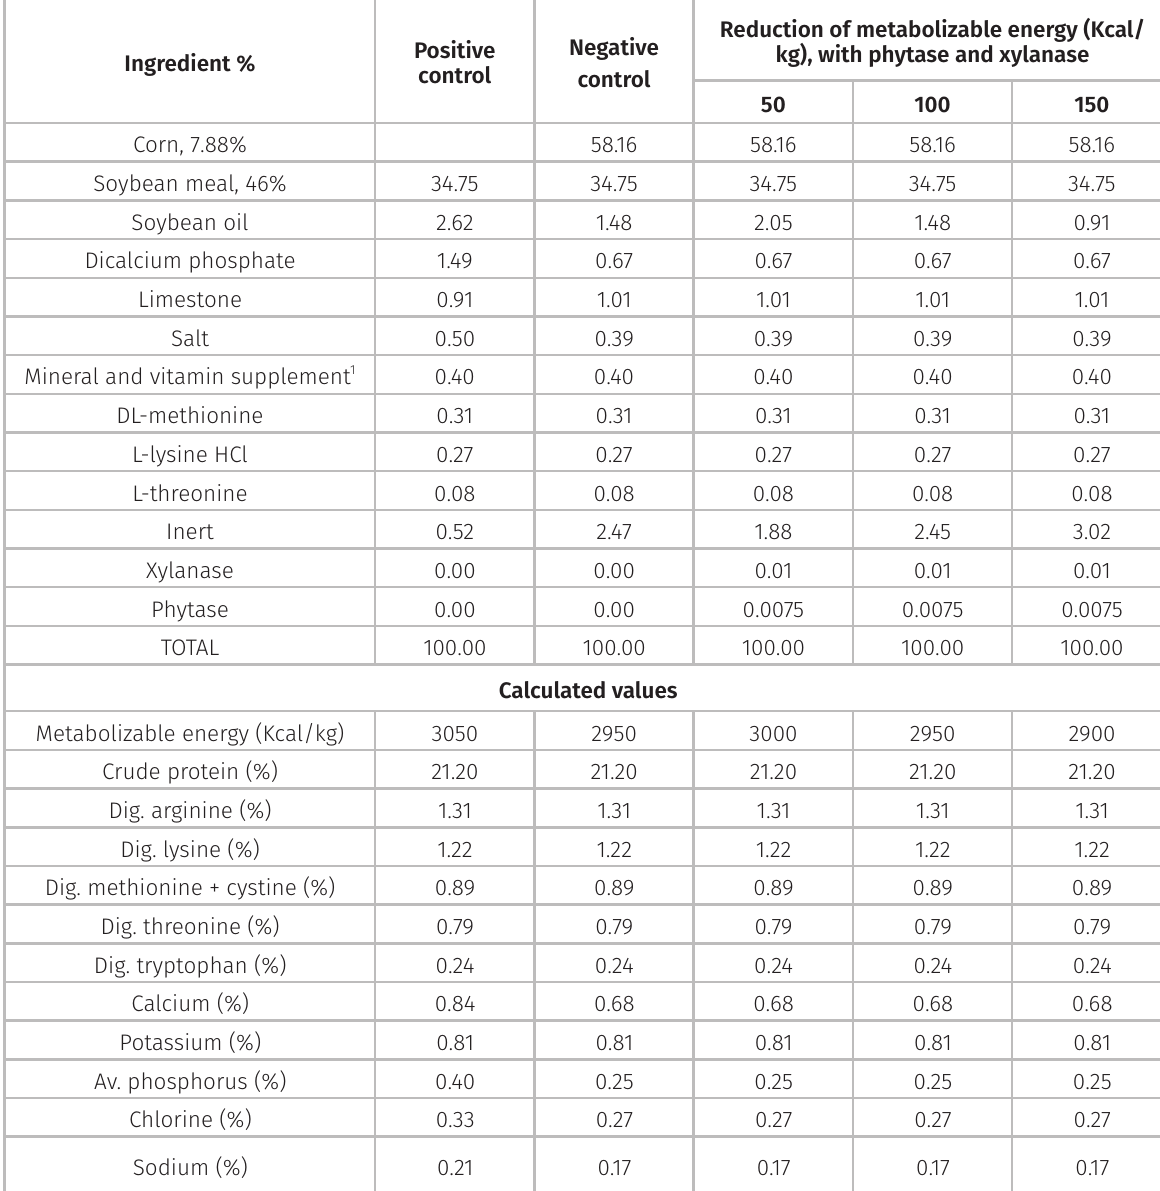
Table II. Centesimal and calculated compositions of experimental diets for broilers in the starter phase (8 to 21